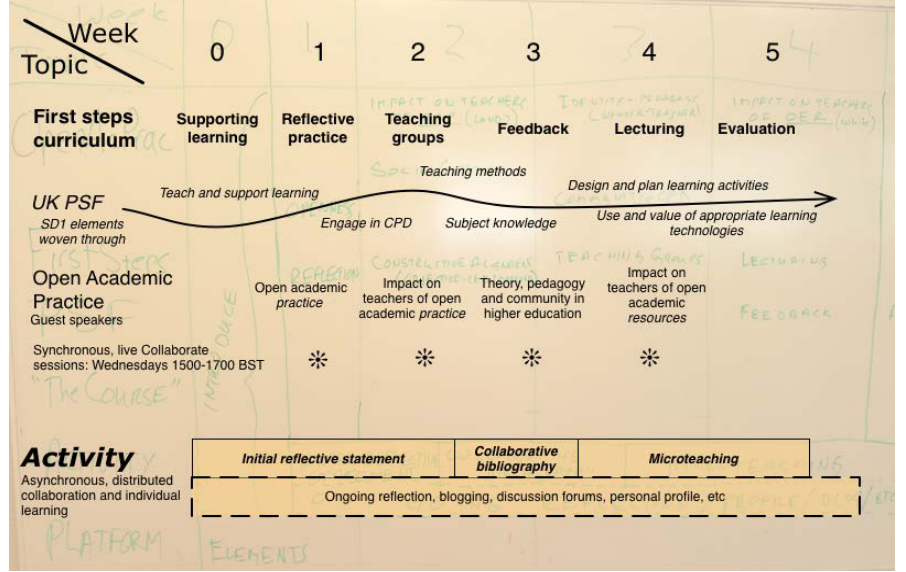
Figure 1: FSLT12 MOOC